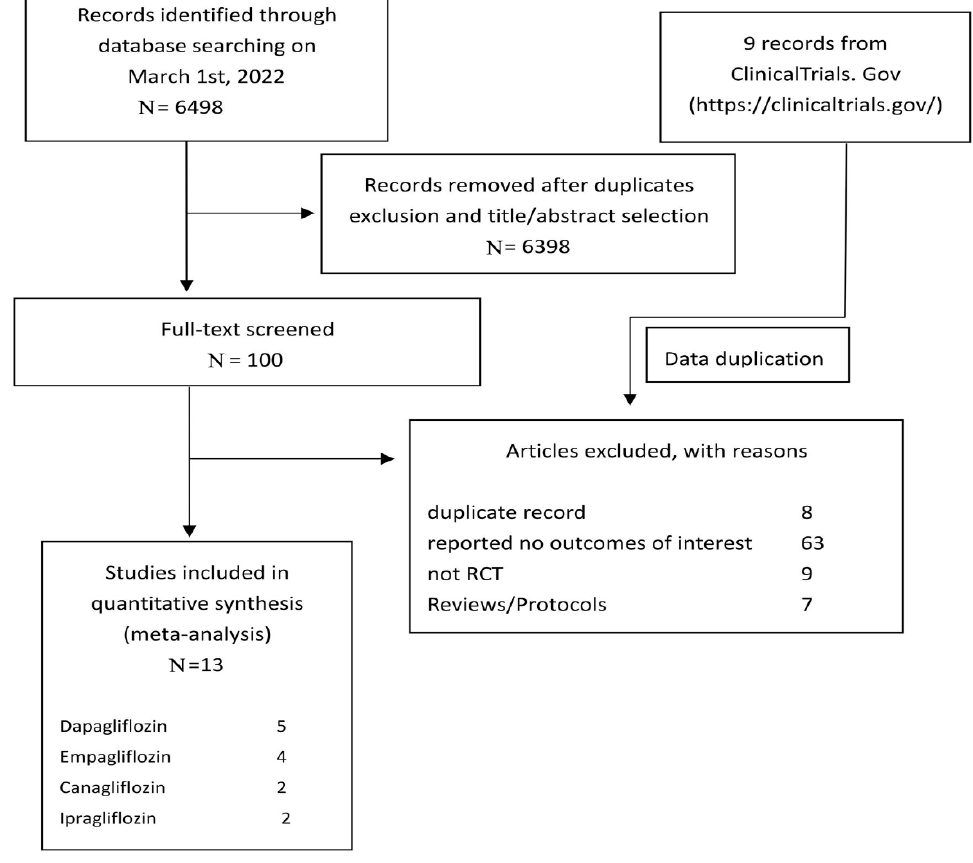
Figure 1. Flowchart for identification and selection of included trials.